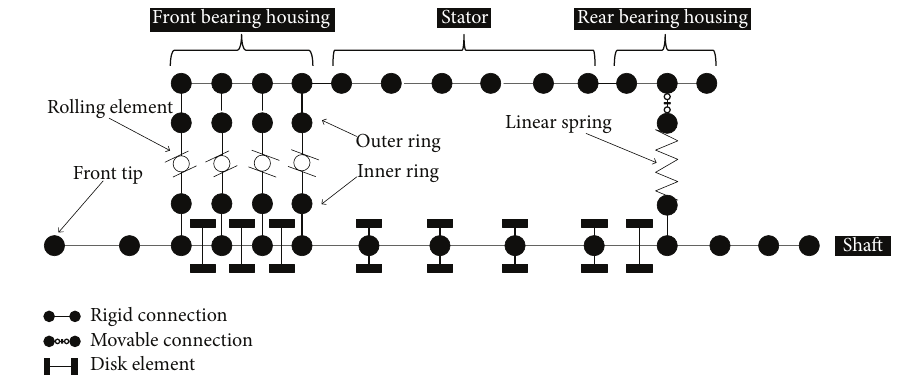
Figure 9: Finite element model of the SBS.